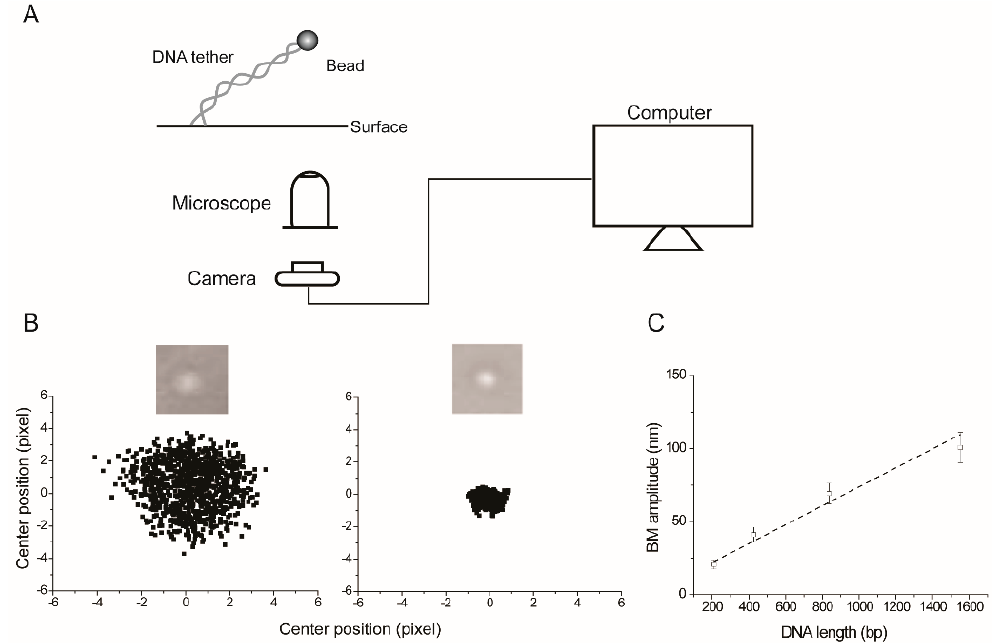
Figure 1. The basic set up for tethered particle motion (TPM) observation and data analysis. ( A ) The polymer being studied (double-stranded DNA in the vast majority of cases) is attached to a planar surface (glass coverslip). Generally, the attachment is mediated by the interaction between digoxigenin placed at one end of the DNA and an antibody to digoxigenin, with which the coverslip is coated. The other end of the DNA tagged by biotin is attached to a bead (generally polystyrene; ~200 nm in diameter) coated with streptavidin. The dynamics of the bead are observed and recorded by an optical microscope fitted with a camera, and connected to a computer. ( B ) The cumulative digitized bead images (from 250 frames; 33 ms for each frame) obtained in two of our experiments with two different DNA molecules are shown here to illustrate the proportionality between the range of bead movement and DNA length. The bead at the right is attached to the shorter DNA. For each frame, the center position of the bead is determined by fitting to a 2D Gaussian distribution. The scatter plots correspond to center positions for bead trajectories over a total of 1000 frames. The Brownian motion (BM) amplitude is estimated as the averaged standard deviation of the center positions along the x and y axes in consecutive 40-frame windows, with a time resolution of 1.32 s per window. ( C ) The estimated BM amplitudes from our experiments plotted here show their empirical relationship (approximately linear) with DNA lengths within the range of a few hundred to a few thousand bp. In the calibration curve, BM amplitude ‘A’ varies with the tether length ‘L’ in bp as A = (0.0648 × L) + 9.0683. The y-intercept is not constrained to be zero when the tether length is zero. An